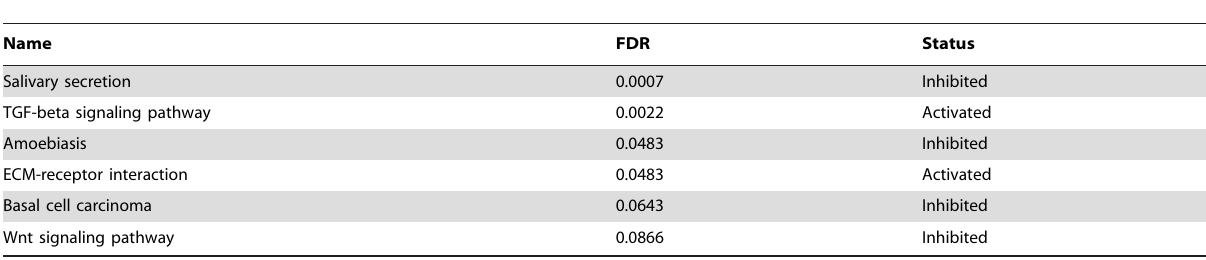
Table 4. SPIA results when provided with DE genes significant at 5% FDR.